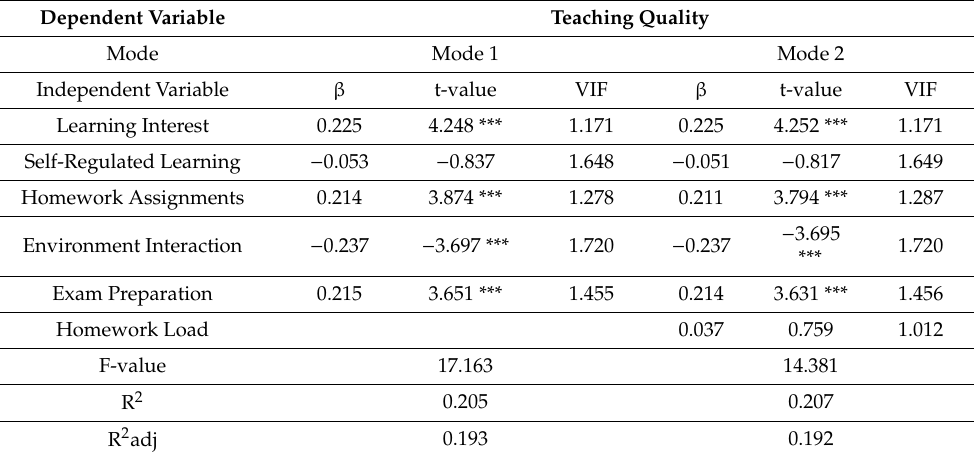
Table 3. Regression analysis of constructs vs. teaching